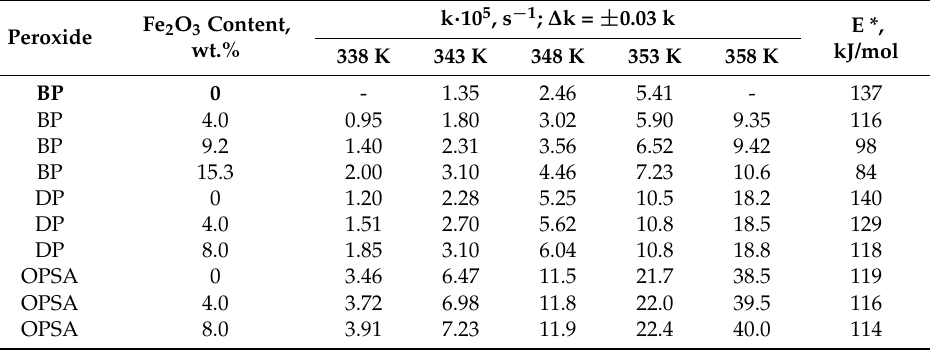
Table 3. The kinetic and activation parameters of thermal decomposition of peroxides in styrene in the presence of Fe 2 O 3 . The concentration of peroxide groups—0.03 mol/L. Peroxide